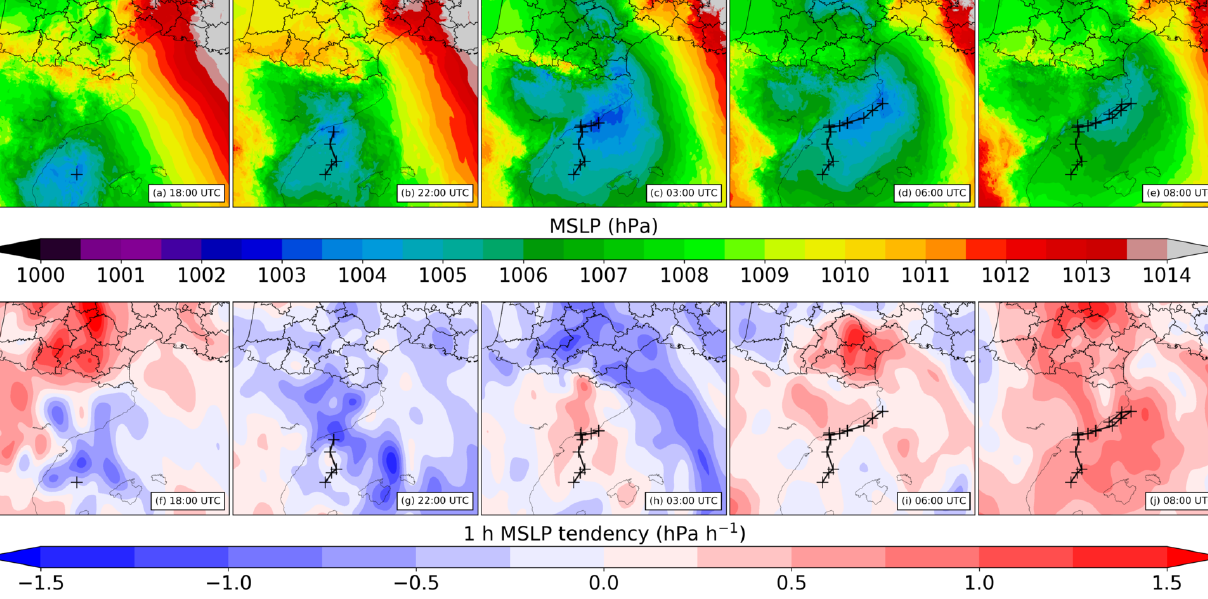
Figure 11. AROME-France analyses of (a–e) MSLP and (f–j) 1h MSLP tendency filtered at 18:00, 22:00UTC on 14 October and 03:00, 06:00, 08:00UTC on 15 October.